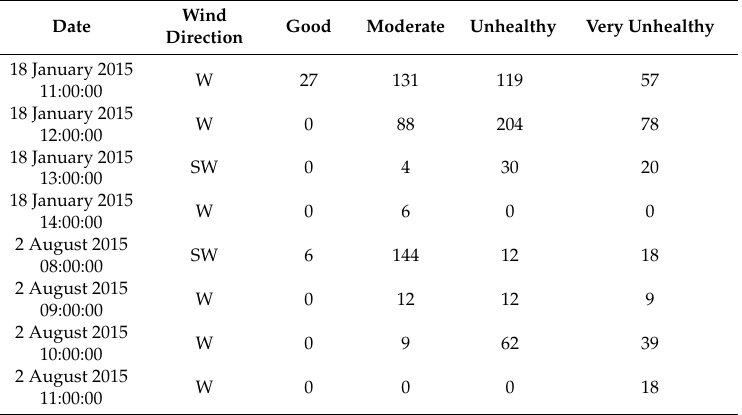
Table 4. The example of the PM data sets.